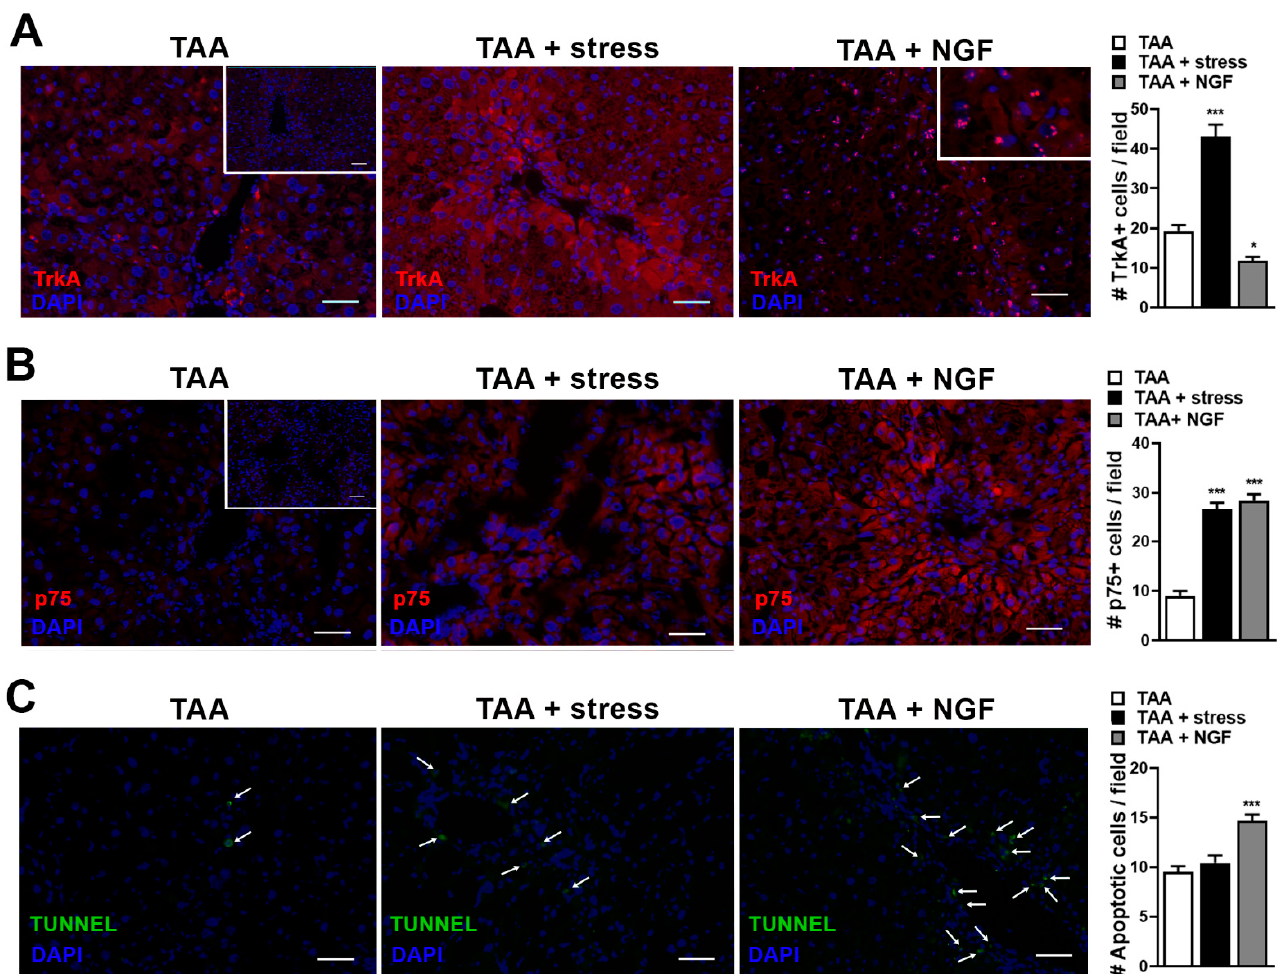
Figure 4. Representative images and number of TrkA + cells/field ± S.E.M ( A ) and number of p75+ cells/field ± S.E.M ( B ) on liver sections of mice with fibrosis (TAA), fibrosis and stress (TAA + stress), and fibrosis and NGF administration (TAA + NGF). *** p < 0.001 and * p < 0.05 vs. TAA (Kruskal–Wallis test). Immunofluorescence negative controls without primary antibodies are shown as inset in left panels. ( C ) TUNEL staining (arrows) and a number of apoptotic cells/field ± S.E.M on the same experimental groups. *** p < 0.001 vs. TAA (Kruskal–Wallis test). Bar = 50 µm.